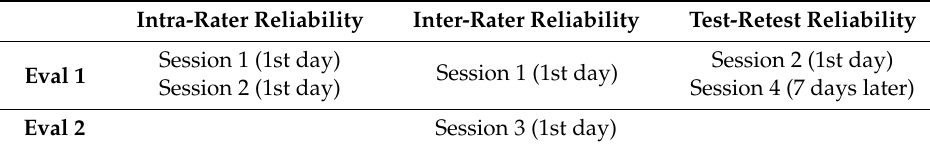
Table 3. Sessions used for reliability estimation.